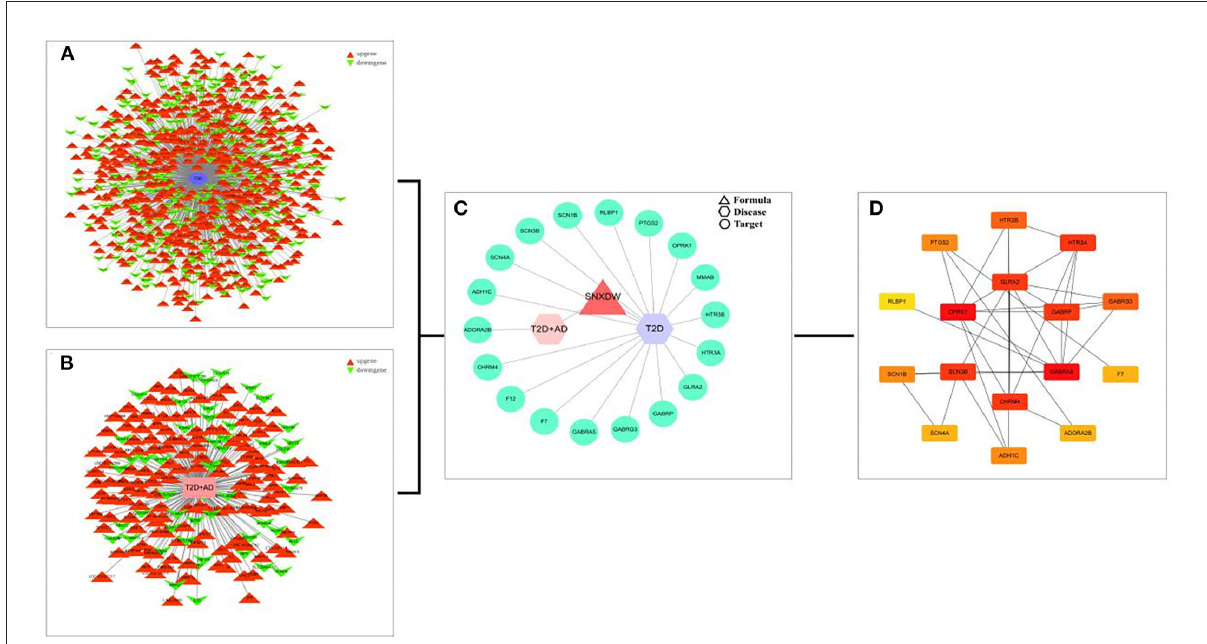
FIGURE4 Interaction networks. (A) GSE138260 differentially expressed genes interaction network. (B) GSE161355 differentially expressed gene interaction network. (C) PPI network was constructed by Shunaoxin pill-disease-target genes. (D) Core 16 potential target genes were calculated based on degree